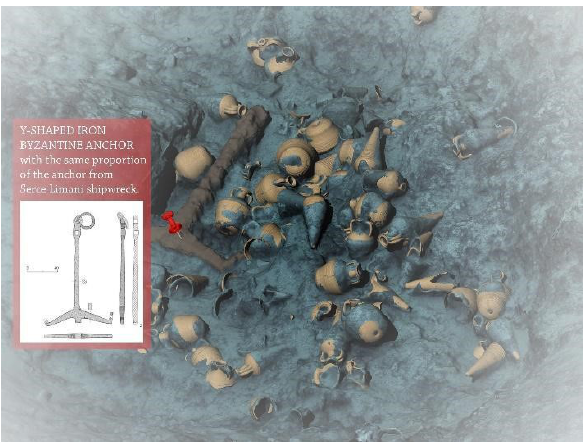
Figure 16. Virtual reality of Cape